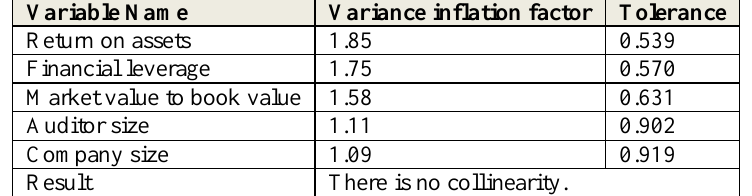
Table 12. Co-linear test of independent variables [Second hypothesis (Model)]